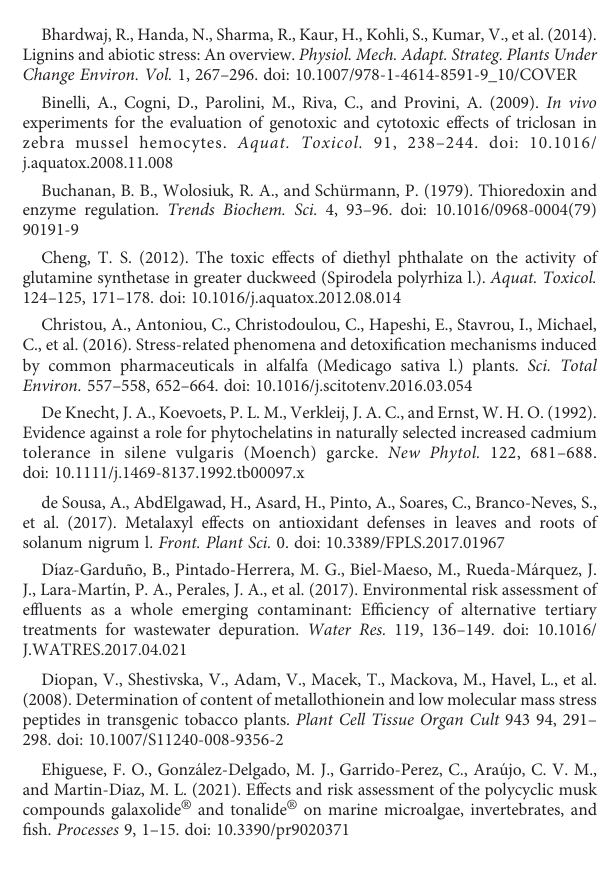
SUPPLEMENTARY FIGURE 1 Rhodospirillum sp. isolate JY3 that had been used in this study. (A) the bacterial colonies on the plate (B) the microscopic examination of the isolate used in this